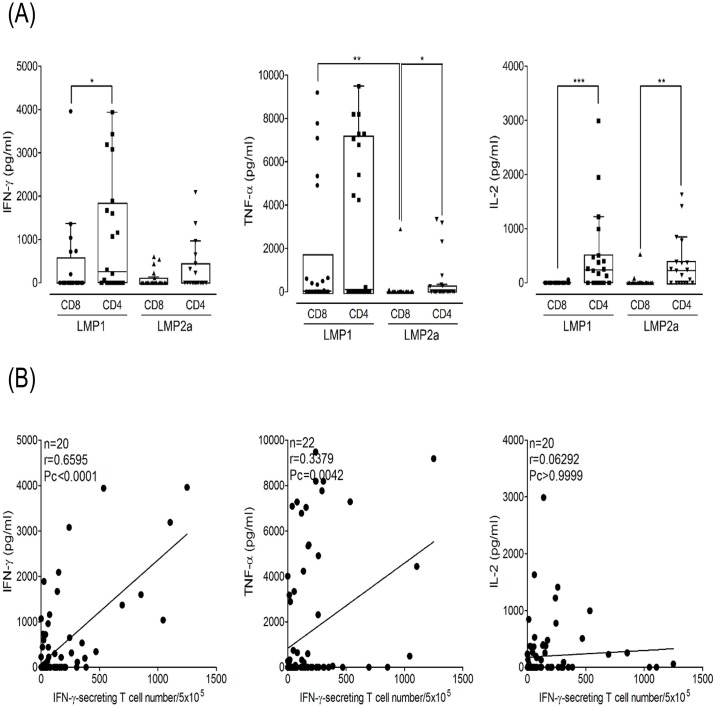
Frequency of LMP1- or LMP2a-specific immune responses by ELISA and comparison of IFN-γ ELISPOT assay.(A) Frequencies of IFN-r (n = 20), TNF-a (n = 22) and IL-2 (n = 20) levels were investigated with supernatant which were secreted in CD8+ and CD4+ T cells stimulated with LMP1 or LMP2a mRNA-transfected DCs. Box and whisker plots (Tukey’s test; 25% ~ 75%) indicate median (middle line in the box) of secreted cytokine level in individuals. (B) Comparison of estimates of cellular immune responses obtained using ELISPOT and cytokine ELISA. The results of the IFN-γ ELISPOT assays correlated well with those from IFN-γ ELISA (n = 20, r = 0.6595, Pc < 0.0001). (*: p < 0.05, **: p < 0.01, ***: p < 0.0001)